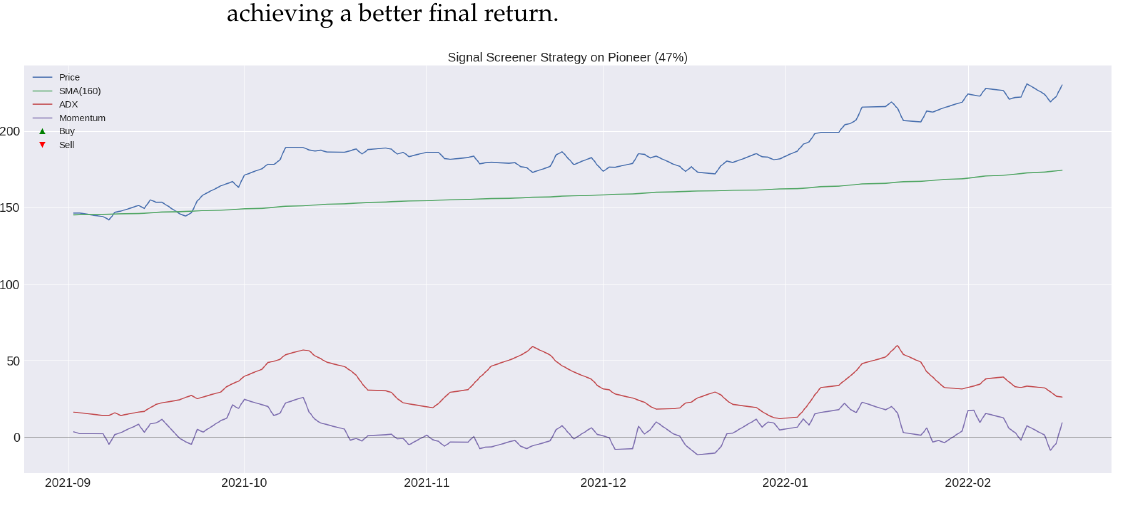
Figure 9. Operations of SiSS over the test period of Pioneer Natural Resources Co.